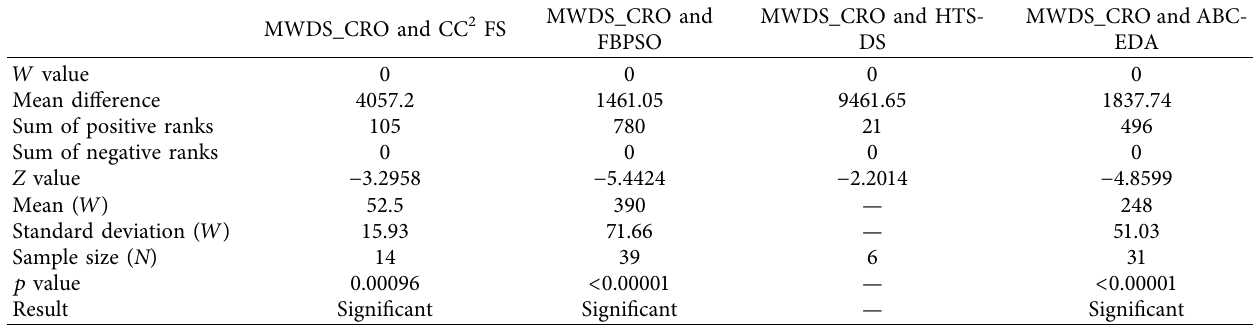
Table 14: Wilcoxon signed-rank test for TII